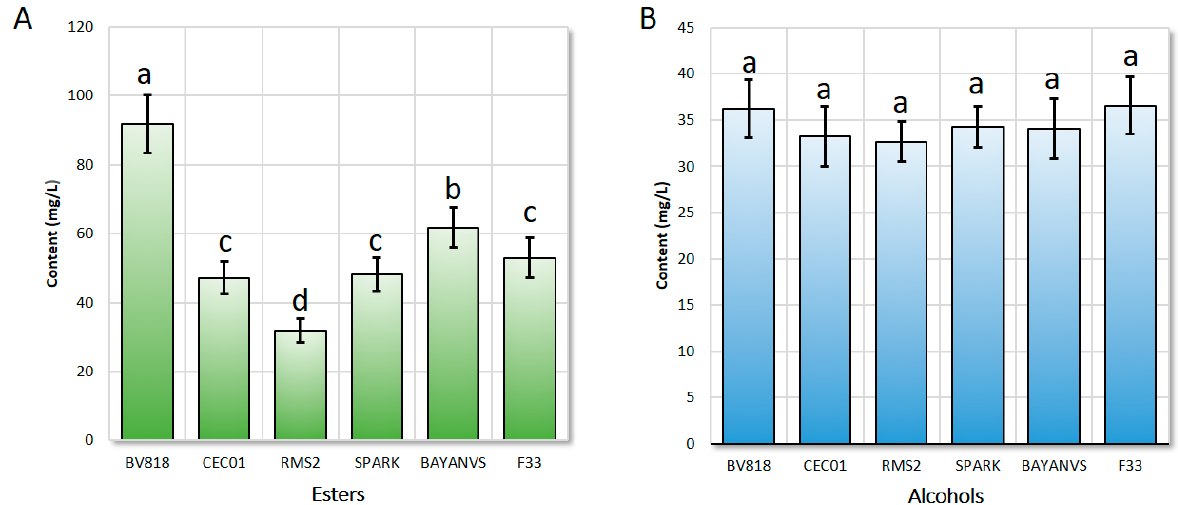
Figure 1. Comparison of the contents of esters ( A ) and alcohols ( B ) of the jujube wine produced by the six winemaking yeasts. Bars with different letters on the top (from a to d) indicate that they have a significant difference from each other. The significance of difference between a and b, c, or d is at a level of 0.001 ( p value); the significance of difference between b and c or between c and d is at a level of 0.05 ( p value); and the significance of difference between b and d is at a level of 0.01 ( p value).